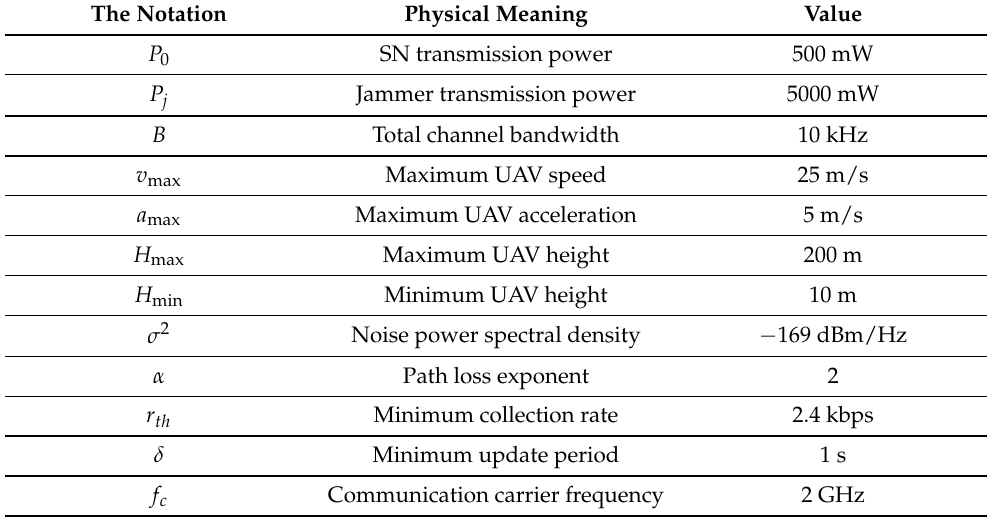
Table A1. Key simulation